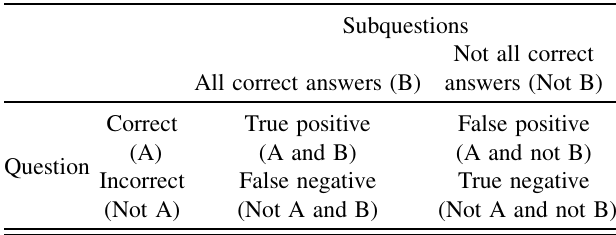
TABLE II. Decision table of answers with subquestions. a